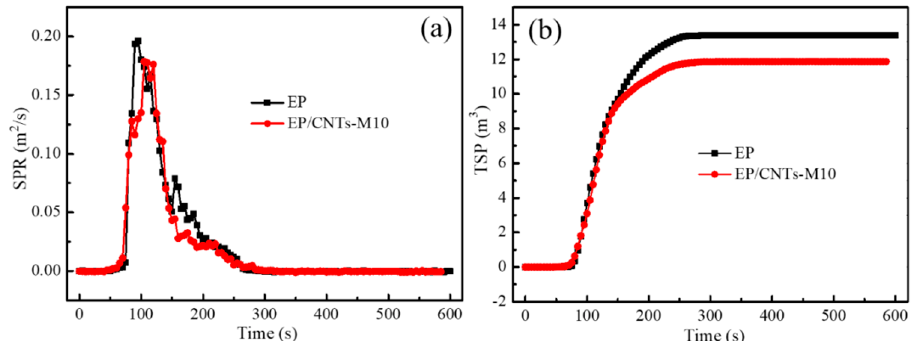
Figure 7. Smoke production rate ( a ) and total smoke production ( b ) versus time curves of EP and composites EP/CNTs-M10.